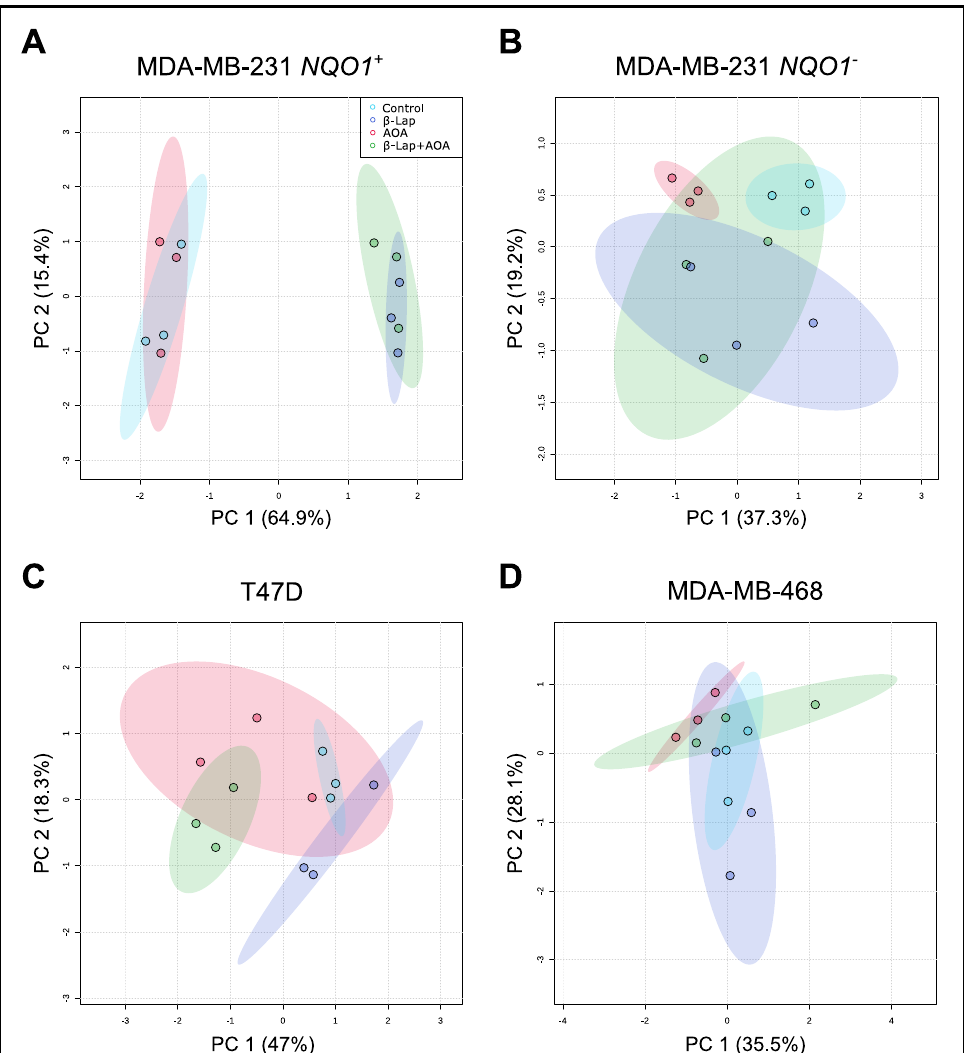
Figure 1. PCA analysis of GC-MS global metabolic profiles of four different breast cancer cell lines treated with either 6 µM β -lap, 100 µM AOA, or a combination of both drugs. Metabolites were analyzed based on internal standard normalized intensity. Panel ( A ) shows clear separation in MDA-MB-231 NQO1 + cells driven by β -lap treatment. Panel ( B ) shows much-reduced clustering in β -lap and β -lap+AOA treatment due to lack of NQO1 in MDA-MB-231 NQO1 − cells. Panel ( C ) shows some separation among control, β -lap, and β -lap+AOA groups in T47D cells. Panel ( D ) shows limited effects in MDA-MB-468 cells, which have almost no NQO1 expression. PCA, principal component analysis; GC-MS, gas chromatography–mass spectrometry; β -lap, β -lapachone; AOA, aminooxyacetic acid; NQO1, quinone oxidoreductase